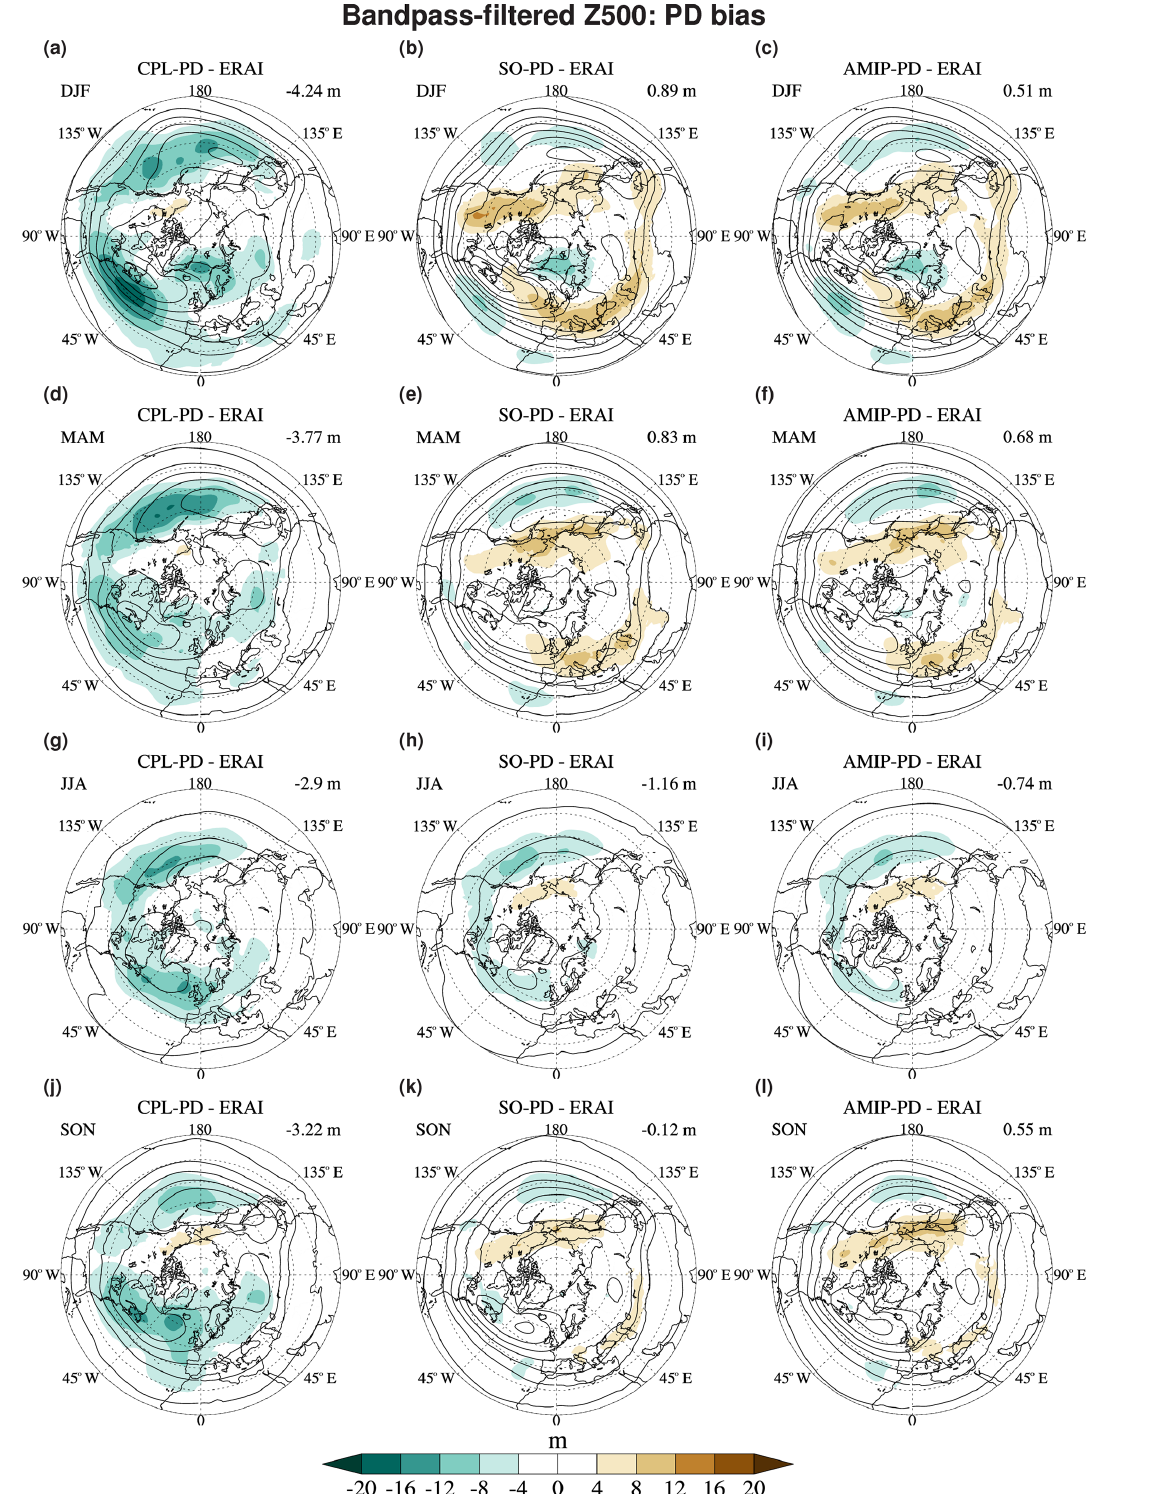
Figure 12. Upper-level storm-track bias relative to ERA-Interim (colours) and climatology (black contours; 8 to 70m in increments of 8m) for the PD experiment from NorESM1-Happi (a, d, g, j) , NorESM1-HappiSO (b, e, g, k) , and NorESM1-HappiAMIP (c, f, i, l) for DJF (a–c) , MAM (d–f) , JJA (g–i) , and SON (j–l) . The storm tracks are represented in terms of bandpass-filtered geopotential height at 500hPa. The bias is computed relative to ERA-Interim for the years 1986–2015. The NorESM data are for the default periods given in Sect. 3. The numbers in the upper-right corners of each plot give the mean bias for the area shown on the plot (latitudes poleward of 20 ◦ N). Units are in metres (a–l) . www.earth-syst-dynam.net/10/569/2019/ Earth Syst. Dynam., 10, 569–598,